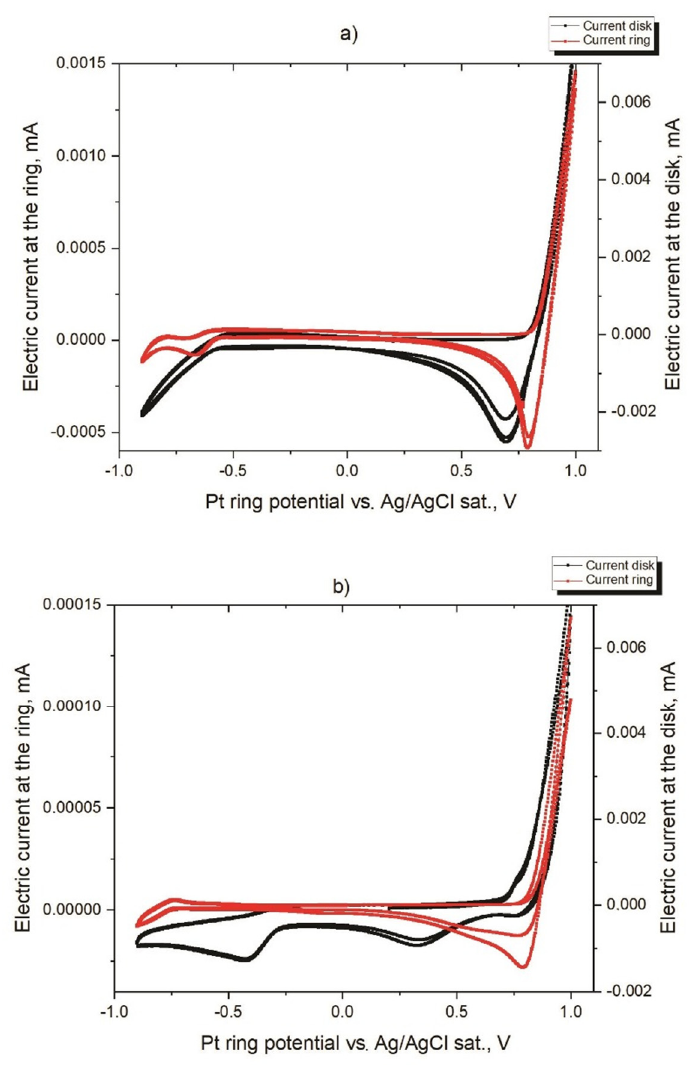
Figure 1. Cyclic voltammograms of 0.5 M NaBr solutions measured at scan rate 50 mV/s at different pH values of buffer solutions at rotating disc and ring: ( a ) pH = 7.02 ( b ) pH = 9.93. Simultaneously, data for these solutions in the form of the ring rotating disc which collected current dependencies are presented in Figure 2.